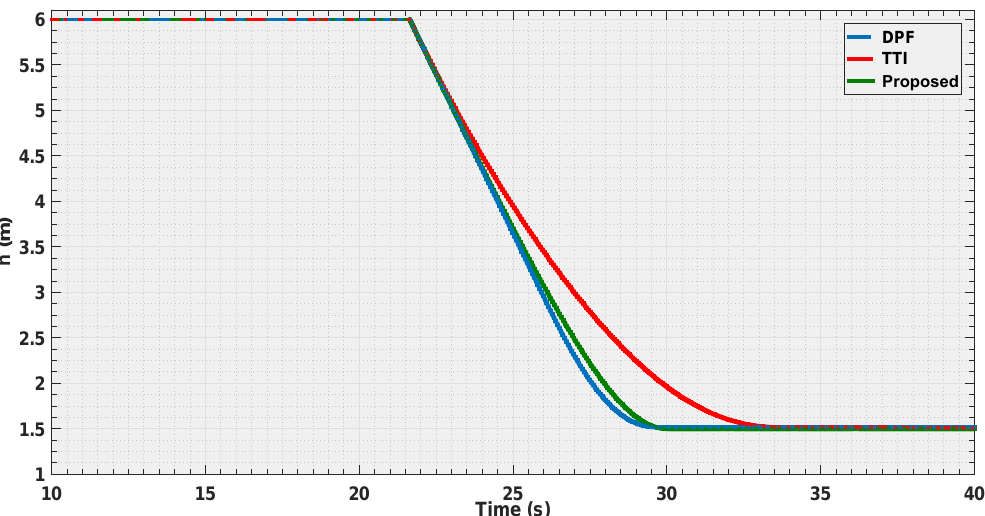
Figure 12. Distance estimation by the three evaluated algorithms Experiment 1